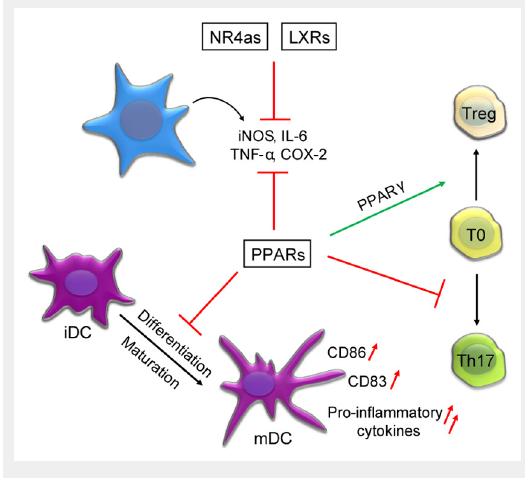
Summary of the key findings on the role of the PPAR, LXR and NR4a family of NRs during inflammation and immune homeostasis. A common feature of these families of NRs are their anti- inflammatory effects that result in the inhibition of the expression of multiple pro-inflammatory cytokines such as inducible NO-Synthase (iNOS), TNF-α, Interleukin-6 (IL-6) and cyclooxygenase-2 (COX-2). PPARs were additionally described to block the maturation of dendritic cells (DCs), which includes an attenuated expression of DC maturation markers such as CD86 and CD83 after activation of this NR sub-family. Also differentiation of T cells into distinct subsets was shown to be influenced by NRs, where PPARs interfere with the differentiation of Th17 cells and simultaneously promote the differentiation of regulatory T cells